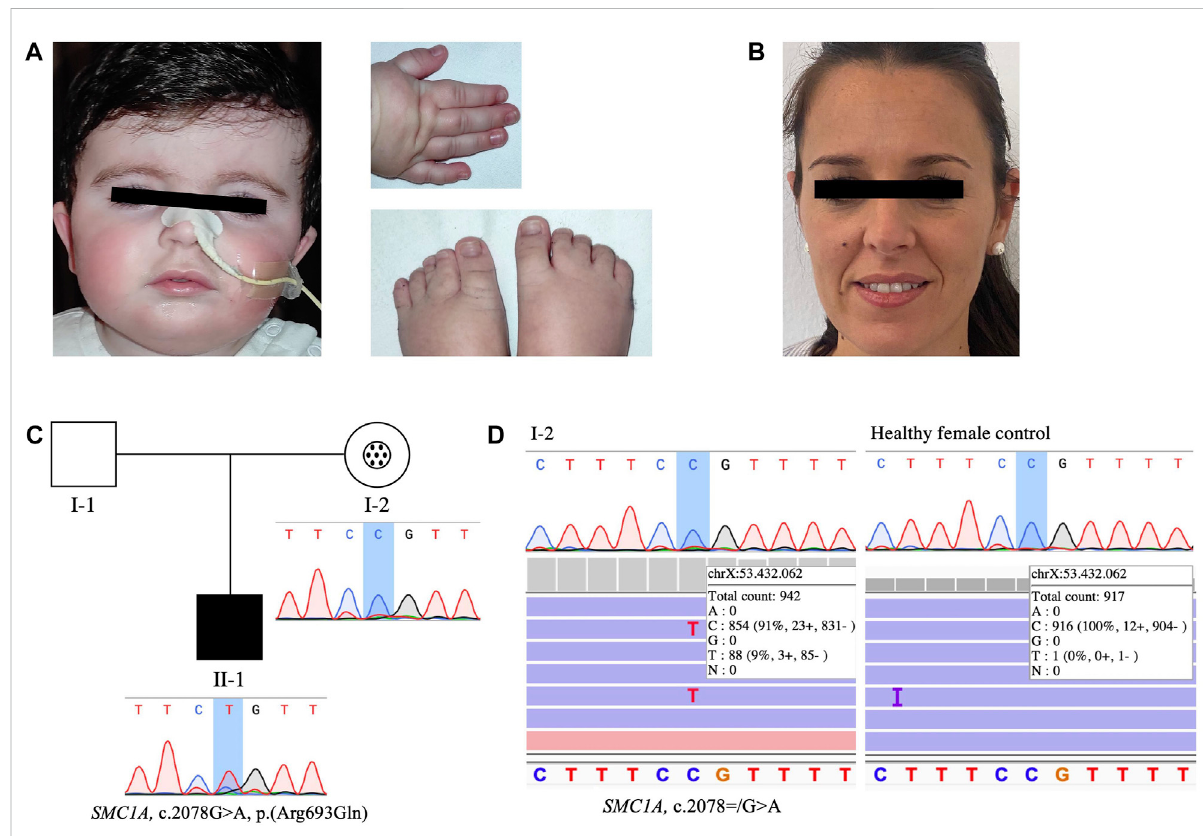
FIGURE 1 Clinical picture, pedigree of the family and sequencing results of the mother ’ s buccal swab DNA. (A) Facial features, right hand and feet of the affected patient. (B) Face of the mosaic carrier mother. (C) Pedigree of the family showing Mendelian transmission of the SMC1A variant and the differentgenotypespresentinmotherandson:blacksymbolrepresentstheaffectedpatientwithheterozygouspathogenicvariant(II-1).Inindividual I-2, the circle in the center of the symbol indicates asymptomatic carrier, and mosaicism condition is highlighted with a black dots pattern inside. Sanger sequencing results of the targeted SMC1A variant [NM_006306.3:c.2078G > A, p. (Arg693Gln)] analyzed in blood-derived DNA of the patient and his mother are shown below their respective representative symbols. The non-affected father (I-1) is indicated as an open symbol. (D) Sanger chromatogram and Integrative Genomics Viewer (IGV) view of sequencing results of the targeted SMC1A variant (NM_006306.3:c.2078 = /G > A) in patient ’ s mother (left) and a healthy female control (right) buccal swab-derived